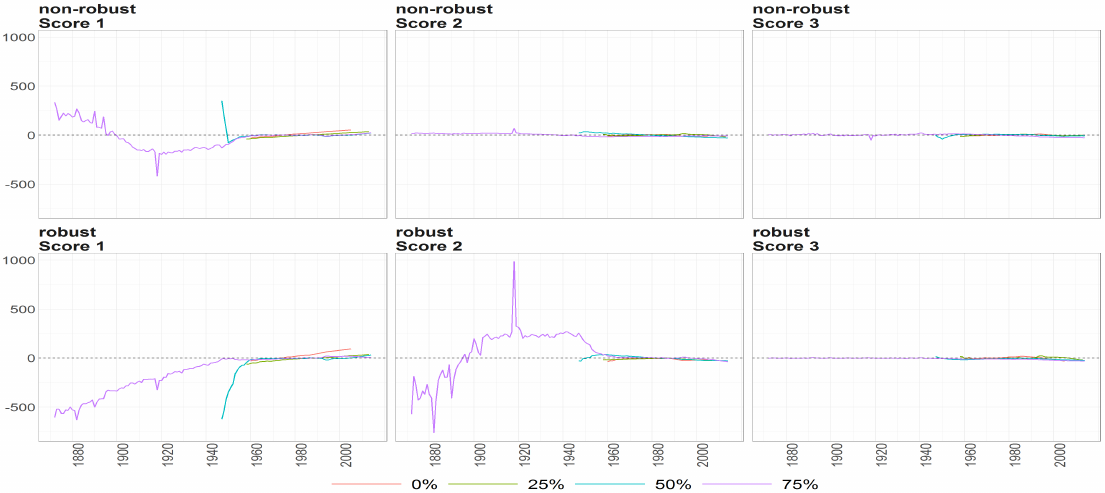
Figure 25. The scores (y axis) over time (x axis) obtained using PPCA for female population of Death Rates. Colours of lines correspond to the scores calculated on subsample where are different levels of maximum missing values per observation (0%, 25%, 50% and 75%, refer to legend). The plots placed in the first row correspond to the results using non- robust standardization of entry data, where the second row correspond to robust standardisation. The plots of scores are ordered by